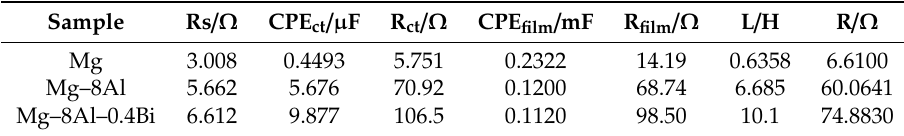
Figure 8. ( a ) Nyquist curves of Mg and Mg alloys. ( b ) Equivalent circuit diagram of Figure 7a measured in 3.5% NaCl solution. Table 3. Parameter values of the equivalent elements in Figure 7.